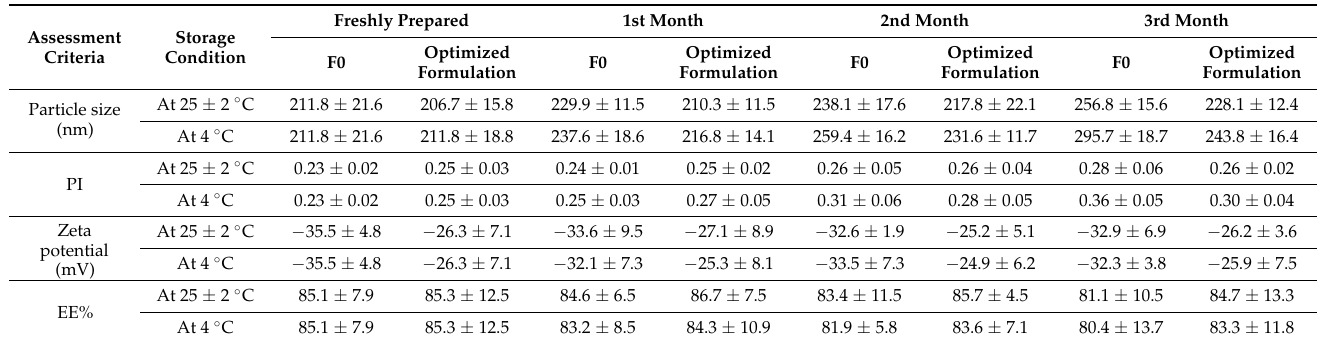
Table 6. Stability studies of optimized formula and F0 (mean ± DS; n =